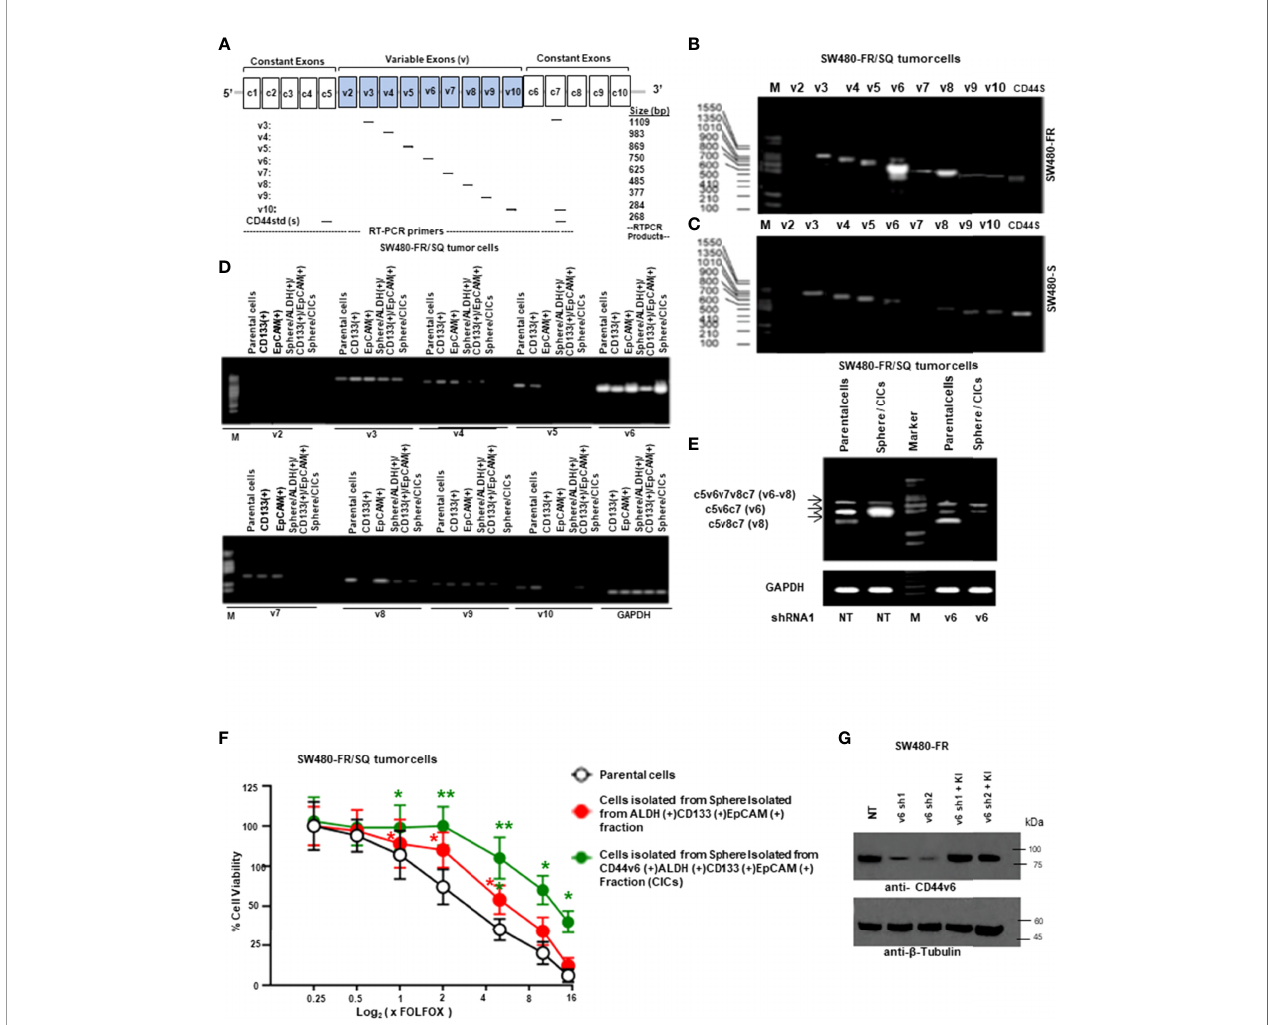
FIGURE 2 | CD44v6 appeared considerably higher in FACS sorted CD133+, ALDH+ and EpCAM+ cells, and in sphere-propagated ALDH+/CD133+/EpCAM+ cells relative to bulk primary cells. (A) , Constant and variable exons are shown for the PCR primers used to amplify CD44 variable (v) and standard (s) isoforms in the human CD44 gene. Primer positions are shown. The expected sizes of the PCR products are indicated. The primers for both the CD44v6 and standard isoforms (CD44s) predominantly generate one PCR product (c5v6c7 [v6] for CD44v6, and C5C7 for CD44s), whereas the primers for the v8 variants amplify two splice variants C5v6v7v8C7 (v6-v8) and C5v8C7 (v8). These PCR products are depicted in panels (B, E) experiments. (B) , SW480-FR cells show a differential expression pro fi le of CD44 isoforms when compared with that of the SW480-S cells (C) . (D) , RT-PCR analyses are shown of CD44 variants (v2-v10) in parental cells, freshly puri fi ed CD133+ cells, EpCAM+ cells, sphere-propagated FACS sorted ALDH1+CD133+EpCAM+, and CD44v6+ALDH1+CD133+EpCAM+ (sphere/CICs) from cells SW480-FR/SQ tumor cells. Normalization was done by using GAPDH as a housekeeping control gene. (E) RT-PCRs are shown for CD44v6, CD44v6-v8, and CD44v8 on Non-targeted control shRNA (NTshRNA) cells and on CD44v6shRNA1 overexpressed in parental cells and in sphere/CICs. GAPDH was used as a housekeeping control gene. (F) , FOLFOX sensitivity was measured in parental cells, in freshly isolated sphere/ALDH1+CD133+EpCAM+ cells, and in sphere/CICs isolated from SW480-FR/SQ tumors grown in serum free medium that were treated with various concentrations of FOLFOX. An ATP based assay (CellTiter-Glo) measured cell viability compared with control cells (without FOLFOX treatment) as 100%. Error bars represent calculated SDs (n = 3). (G) Validations of two shRNAs for CD44v6 used in panel (E) were done by the indicated shRNA mediated knockdown and the corresponding knock-in (KI) gene transfections as described in Methods. Target proteins were analyzed by WB analysis ( b -tubulin, internal control). Data are presented as Mean ± SD from n = 3 – 5 independent replicates in three independent experiments. All semi quantitative RT-PCR and western blot data are representative of three experiments. *, P < 0.05, **, P < 0.01 were considered signi fi cant, percent cell viability in ALDH (+)/CD133 (+)/EpCAM (+), and from CD44v6 (+)/ALDH (+)/CD133 (+)/EpCAM (+) fractions compared with control parental cell. Student ’ s t-test was used to assess the signi fi